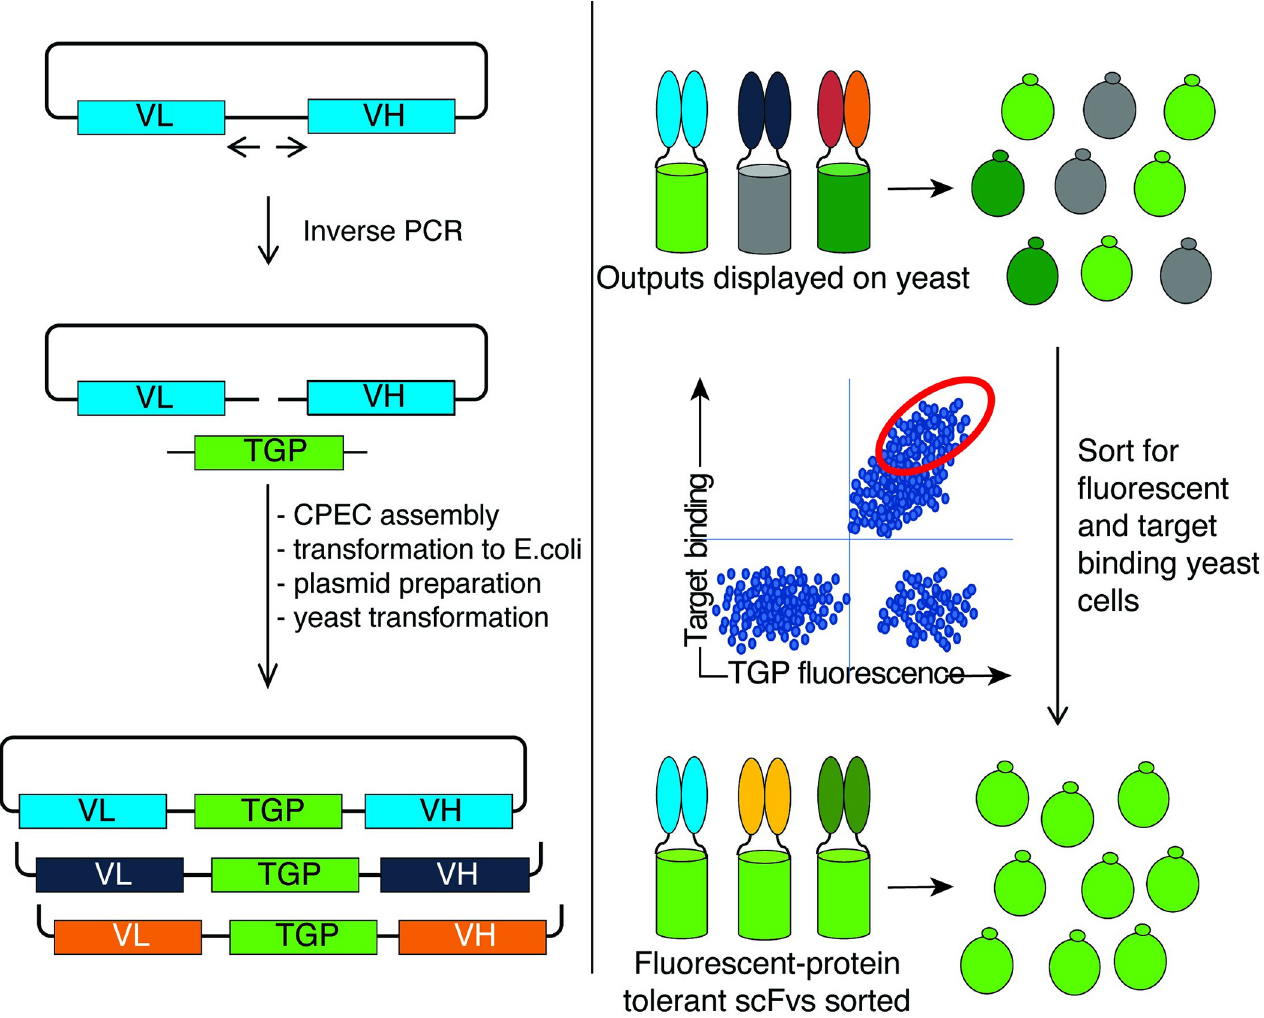
Fig 2. Schematic depicting scFP library preparation and sorting to obtain antibodies tolerant to fluorescent protein insertion. The selected scFv library is amplified by inverse PCR and CPEC assembly is used to build the scFP library. This library is displayed on yeast and sorted for antigen recognition and fluorescence. The sorted library is cloned into protein expression vectors for scFP